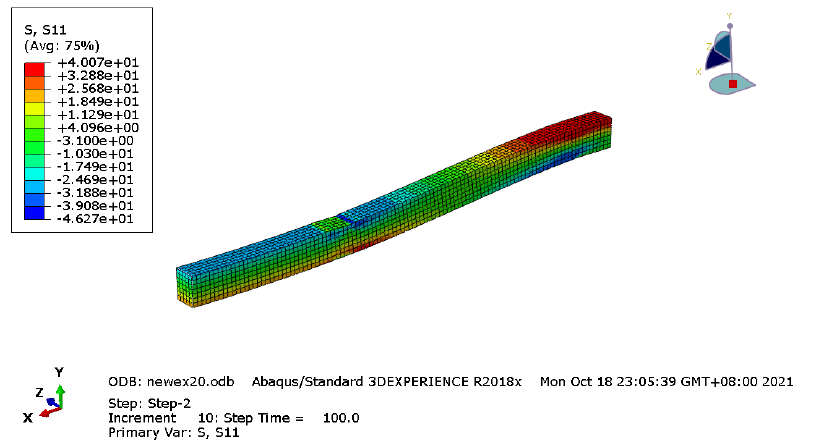
Figure 16. Stress